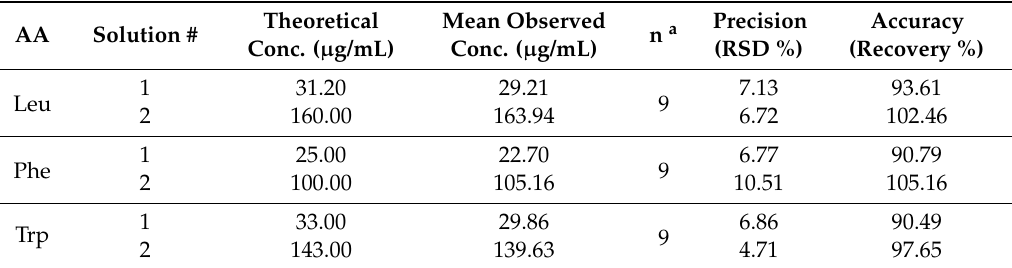
Table 3. The statistical analysis of the three selected amino acids in the long period (inter-day precision and accuracy